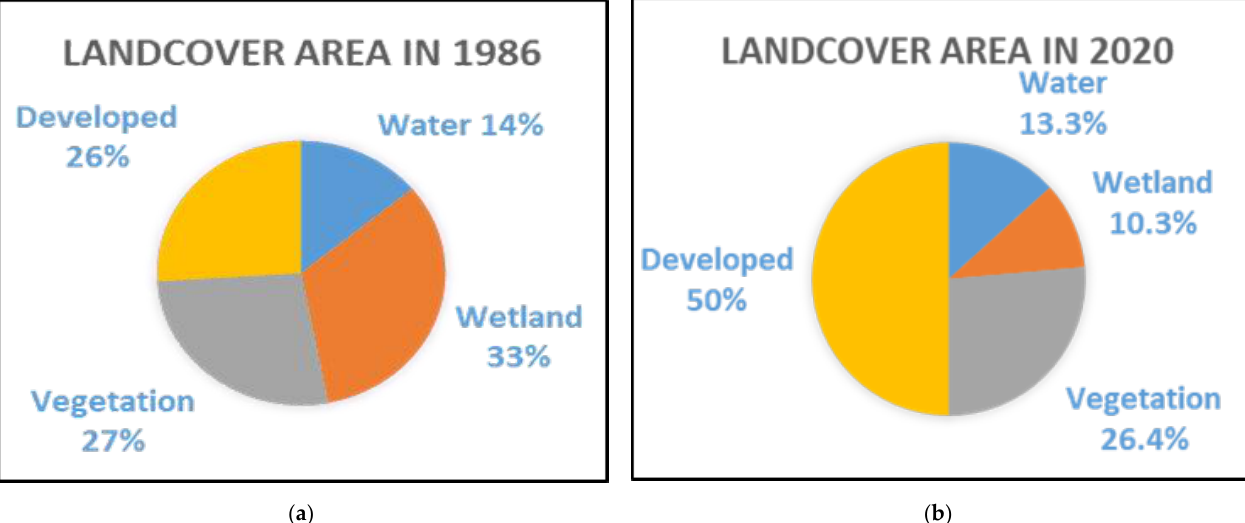
Figure 4. LULC classification maps for ( a ) 1986, ( b ) 2000, ( c ) 2016, and ( d ) 2020 for the State of Lagos, Nigeria.